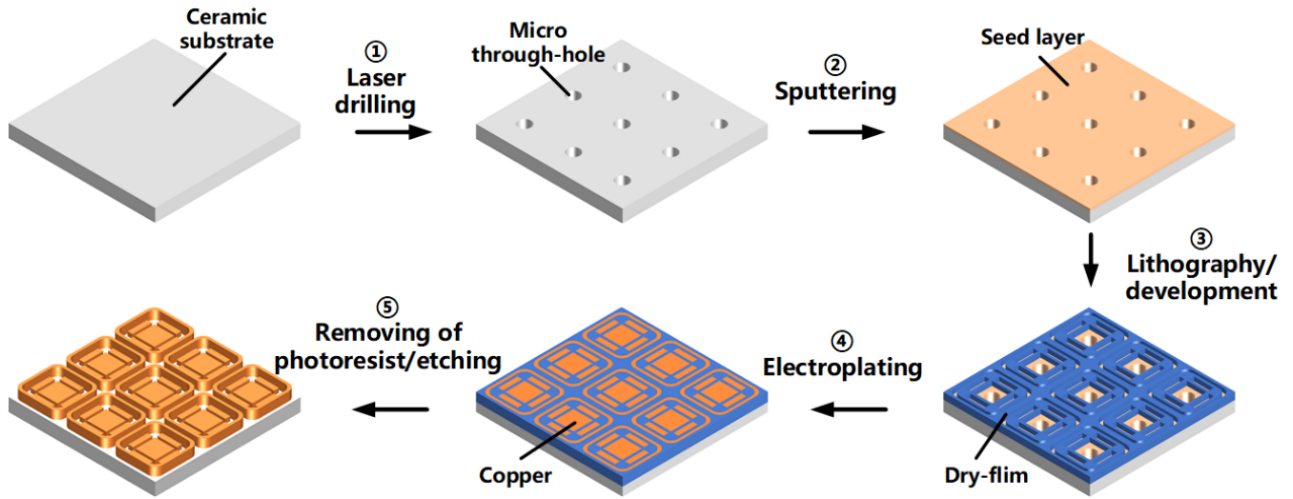
Figure 1. The process of THs filling on the ceramic substrate. The effect of each additive and the improvement of copper coating properties using additive compounds with Cl − was examined by observing the THs cross-section and de- tecting the copper coating properties. The copper filling processes of the THs were ob- tained using an optical microscope (VHX-6000, KEYENCE, Osaka, Japan), and the throw- ing power (TP) was also calculated by using the coating thickness ratio at the THs’ center to that near the hole mouth to determine the filling capability. The micromorphologies of the coatings were observed using a field emission scanning electron microscope (FSEM, GeminiSEM300, Zeiss, Oberkochen, Germany). The copper coating texture was explored using an X-ray diffractometer (XRD, Empyrean, PANalytical, Almelo, Netherland), and the grain size and preferred orientation were calculated using the Scherrer Equation and Formula (1), respectively. I (hkl) and I 0 (hkl) are the diffraction intensities of the (hkl) plane measured in the diffractogram for the copper coatings and the standard copper sample. The copper coating corrosion resistance was measured using potentiodynamic polariza- tion curves with 3.5 wt.% NaCl in the three-electrode system. The tested copper coating (1 × 2 cm 2 ) is the WE, the saturated calomel electrode (SCE) as the RE, and the Pt sheet (2 × 2 cm 2 ) is the CE. The open circuit potential (E OCP ) was obtained as a function of an expo- sure time of 0.5 h, and the polarization curves were then recorded from − 0.3 V vs. SCE to 0.3 V vs. SCE.